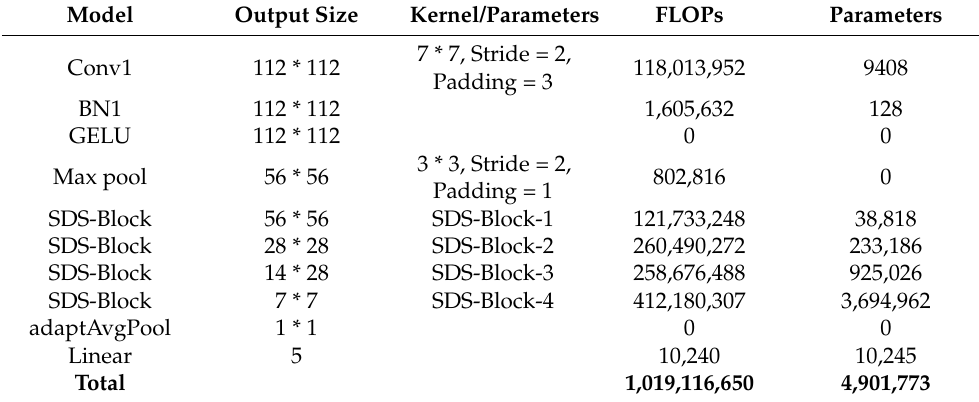
Table 2. Structure of algorithm model.